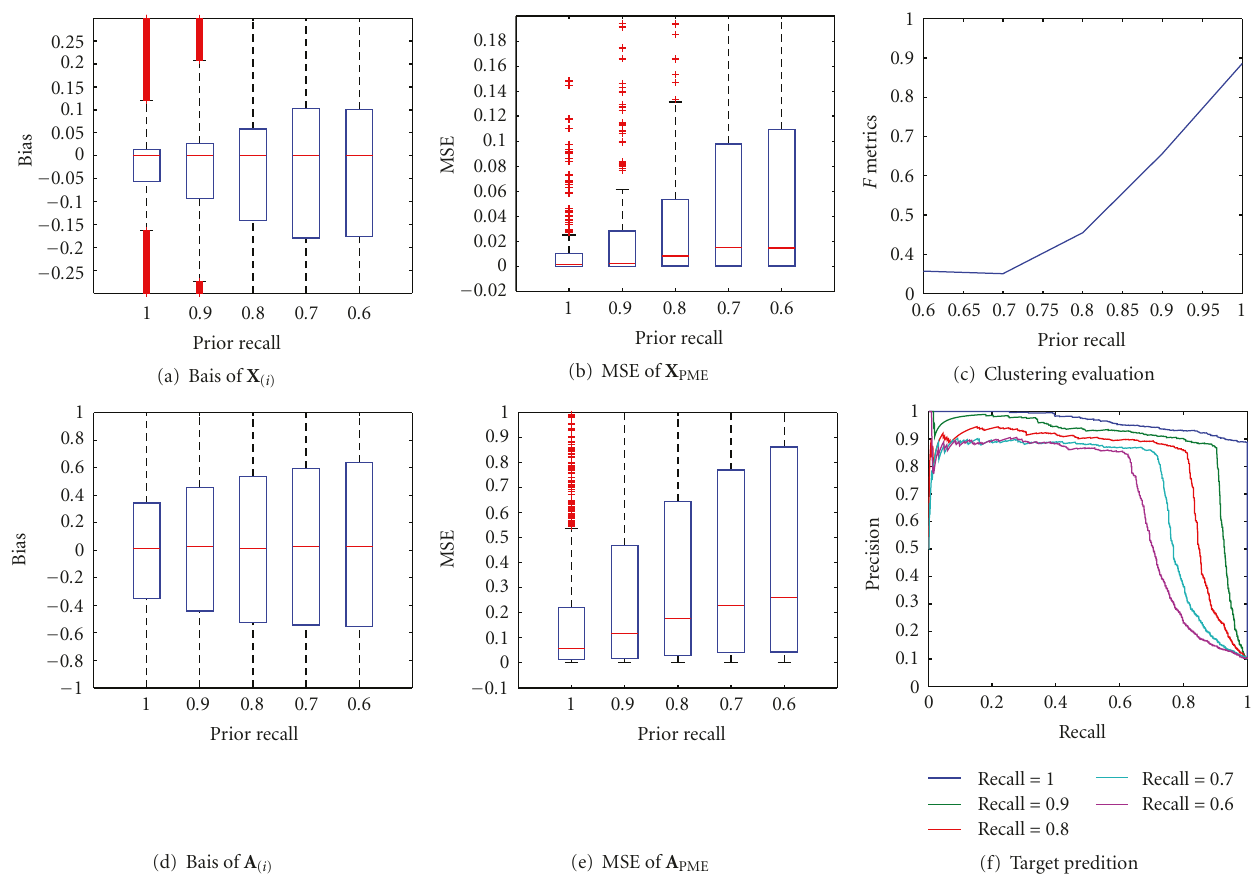
Figure 5: Performance of BSCRFA when recall of prior knowledge is di ff erent.